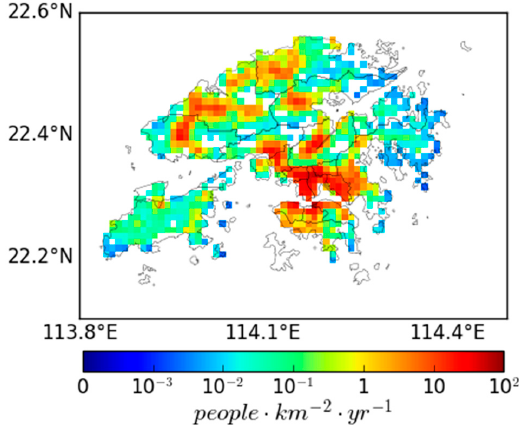
Figure 5. Spatial distribution of the density of annual premature mortality attributable to PM 2.5 for adults over Hong Kong in 2015.